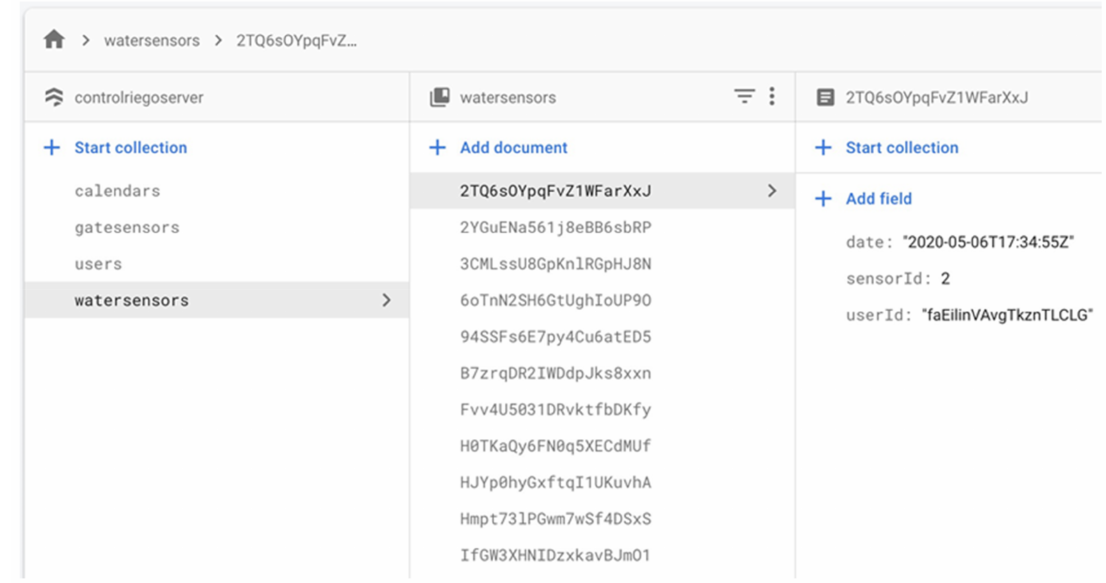
Figure 16. Structure for the detection collection of water sensors in the database (panel of Firebase Cloud